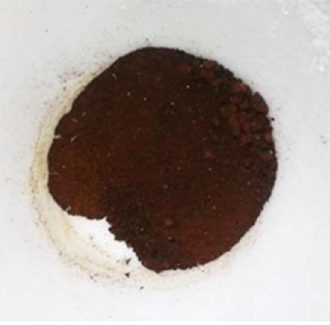
Figure 2. Digital photograph of hematite nanoparticles.